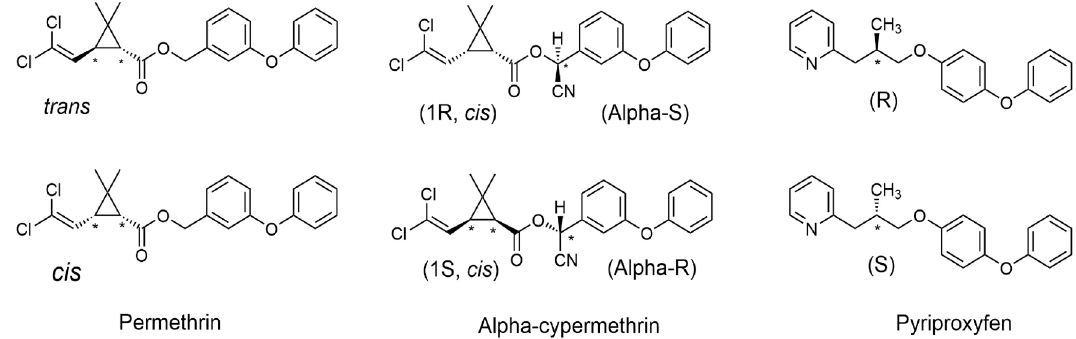
Figure 1. Chemical structure of permethrin, alpha-cypermethrin and pyriproxyfen insecticides (*: chiral centres).